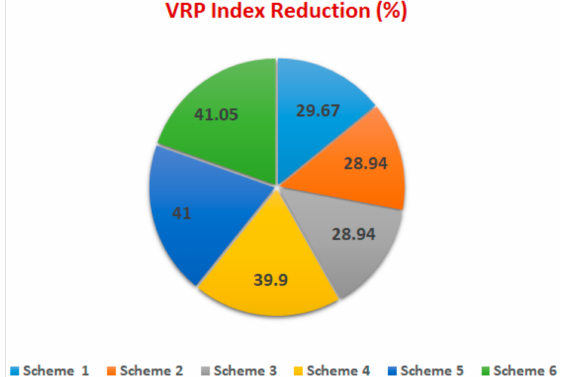
Figure 11. VRP index reduction in the modified IEEE 33-bus system.